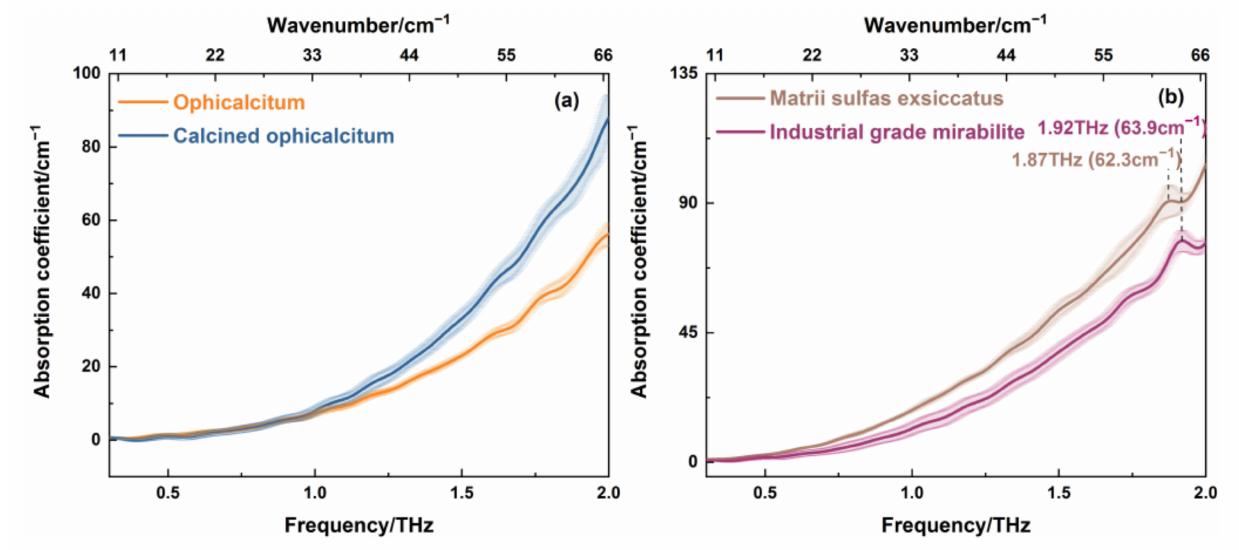
Figure 8. The THz absorption coefficients of ( a ) ophicalcitum and its calcined product, and ( b ) matrii sulfas exsiccatus and industrial-grade